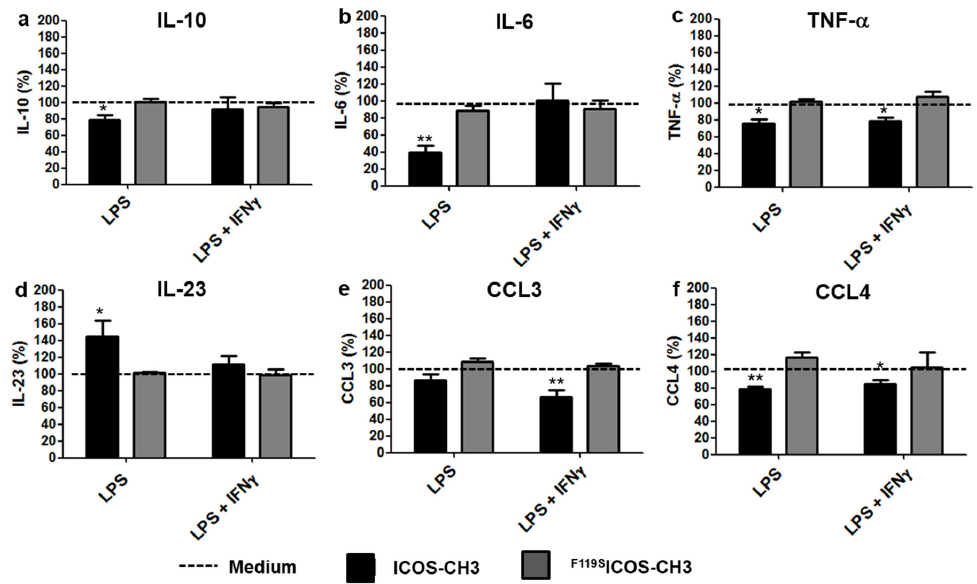
Figure 3. Effect of ICOS-CH3 on cytokine/chemokine secretion of M1 cells in the presence of LPS. M1 MDMs were cultured in DM + LPS in the presence or absence of IFN γ plus ICOS-CH3 or F119S ICOS-CH3. Culture supernatants were harvested after 2 d and examined for IL-10 ( a ), IL-6 ( b ), TNF- α ( c ), IL-23 ( d ), CCL3 ( e ), and CCL4 ( f ) production by ELISA. Data represent the mean and SEM expressed as a percentage of results from five/six independent experiments. The corresponding samples cultured in the absence of ICOS-CH3 or F119S ICOS-CH3 were set at 100% (whose absolute data are shown in Figure S2). * p < 0.05, ** p < 0.01 vs . the corresponding 100% control. In LPS-treated M2 cells, ICOS-CH3 reduced TNF- α and CCL3 secretion. Conversely, in LPS + IL-4 treated M2 cells, ICOS-CH3 increased secretion of IL-10, IL-6, CCL3 and CCL4, whereas IL-23 was always undetectable [21]. Treatment with F119S ICOS-CH3 did not exert any effect under any stimulatory conditions (Figure 4).